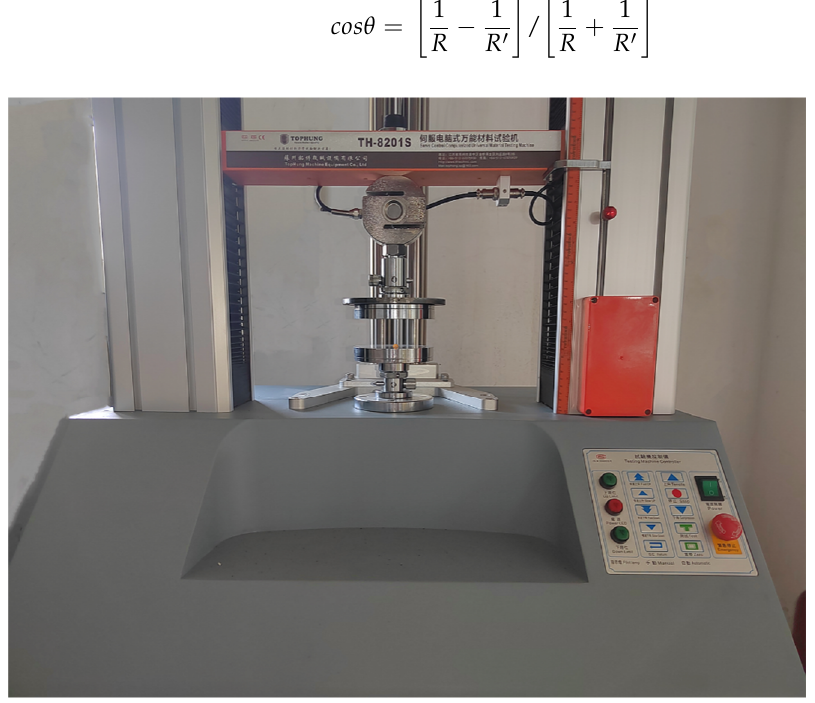
Figure 8. Compression test by a universal testing machine.